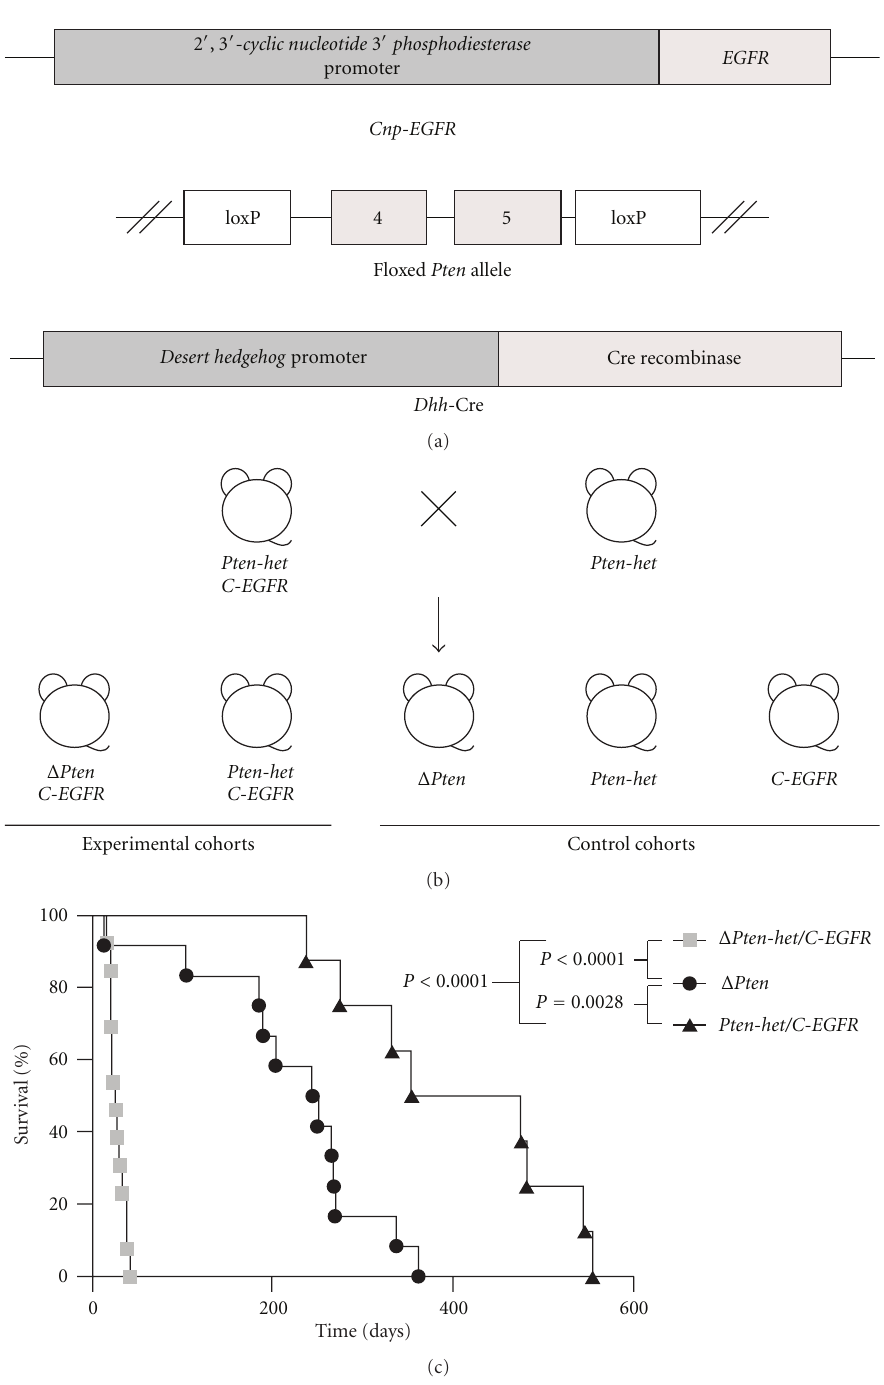
Figure 1: Establishing a novel sporadic peripheral nerve sheath tumor (PNST) progression mouse model. (a) Transgenes used to establish the novel sporadic PNST mouse model. Cnp - EGFR consists of the Cnp regulatory elements driving the EGFR gene expression specifically in Schwann cells and/or their precursor cells. Floxed Pten allele consists of the essential exons 4 and 5 of the Pten gene floxed with loxP sites. Dhh -Cre consists of the Dhh regulatory elements driving Cre recombinase to remove the loxP sites and allow for the inactivation of the floxed Pten alleles specifically in Schwann cells and/or their precursor cells. (b) Breeding strategy for generating experimental and control animals. Transgenic mice each carrying a single transgene was bred to obtain doubly transgenic mice Dhh -Cre; Pten flox/ + mice ( Pten - het ). Doubly transgenic mice were then bred with remaining transgene to obtain triple transgenic Dhh -Cre; Pten flox/ + ; Cnp - EGFR mice ( Pten - het / C - EGFR ). Finally, Pten - het mice were bred with Pten - het / C - EGFR mice to obtain the required experimental and control cohorts. Dhh -Cre; Pten flox/flox ; Cnp - EGFR ( Δ Pten / C - EGFR ) and Dhh -Cre; Pten flox/ + ; Cnp - EGFR ( Pten - het / C - EGFR ) experimental cohorts. Dhh -Cre; Pten flox/flox ( Δ Pten ), Pten - het and Cnp - EGFR ( C - EGFR ) control cohorts. (c) Kaplan-Meier survival curves of various experimental and control cohorts. Pten dosage augmented the peripheral nervous system phenotype in the context of EGFR overexpression in Schwann cell and/or their precursor cells, resulting in decreased survival. P : log-rank